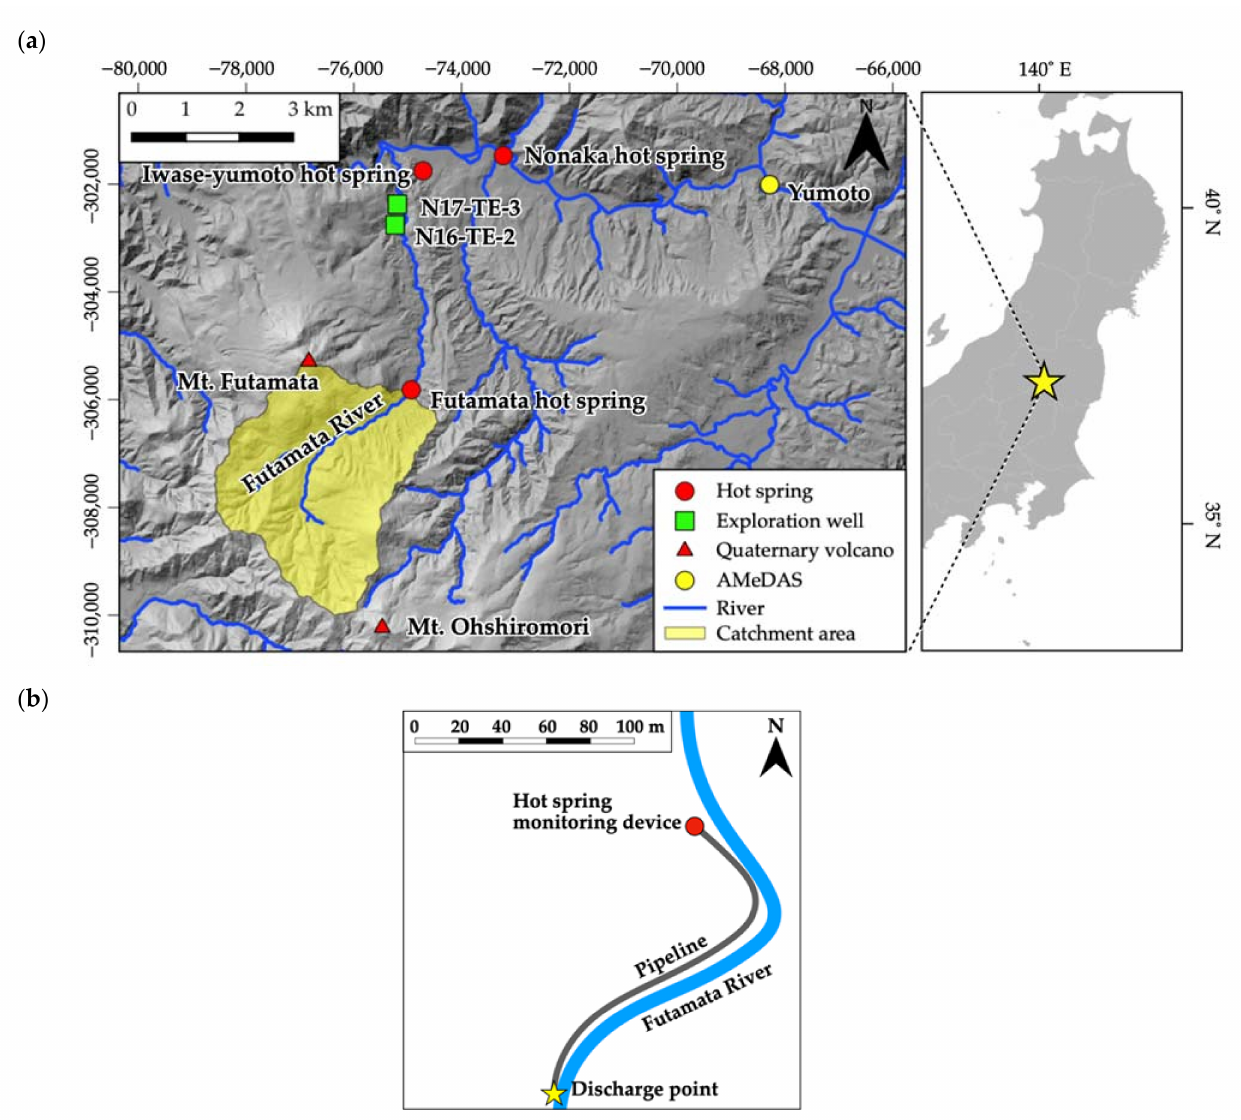
Figure 1. Location of study areas. ( a ) Shadow relief map. This map is based on 10-m grid digital elevation models (DEMs) from the Geospatial Information Authority of Japan. ( b ) Schematic diagram showing the location of the hot spring monitoring